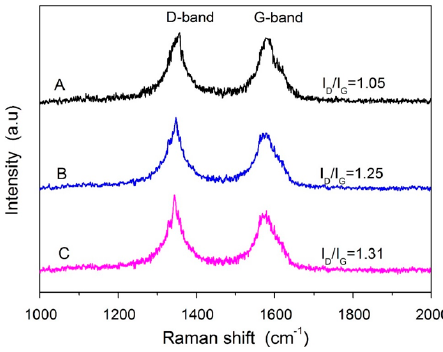
Figure 3. Raman spectra of pristine and surface modified MWCNTs: ( A ) Pristine CNT, ( B ) A-CNT, ( C ) K-CNT.